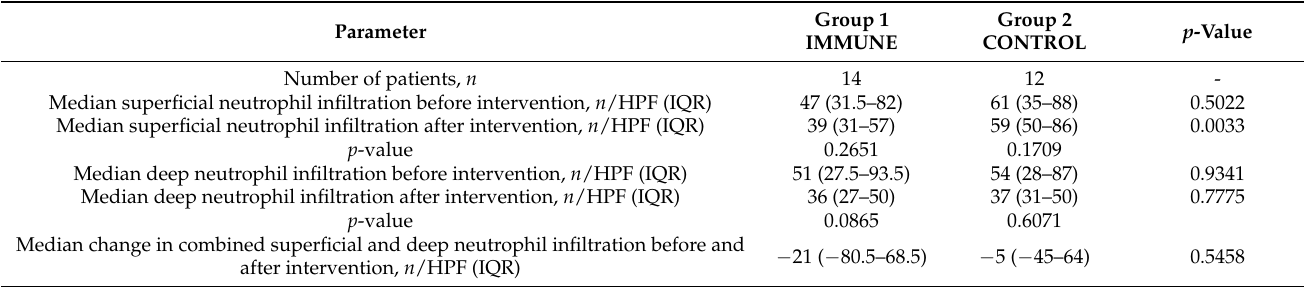
Table 4. Histopatological